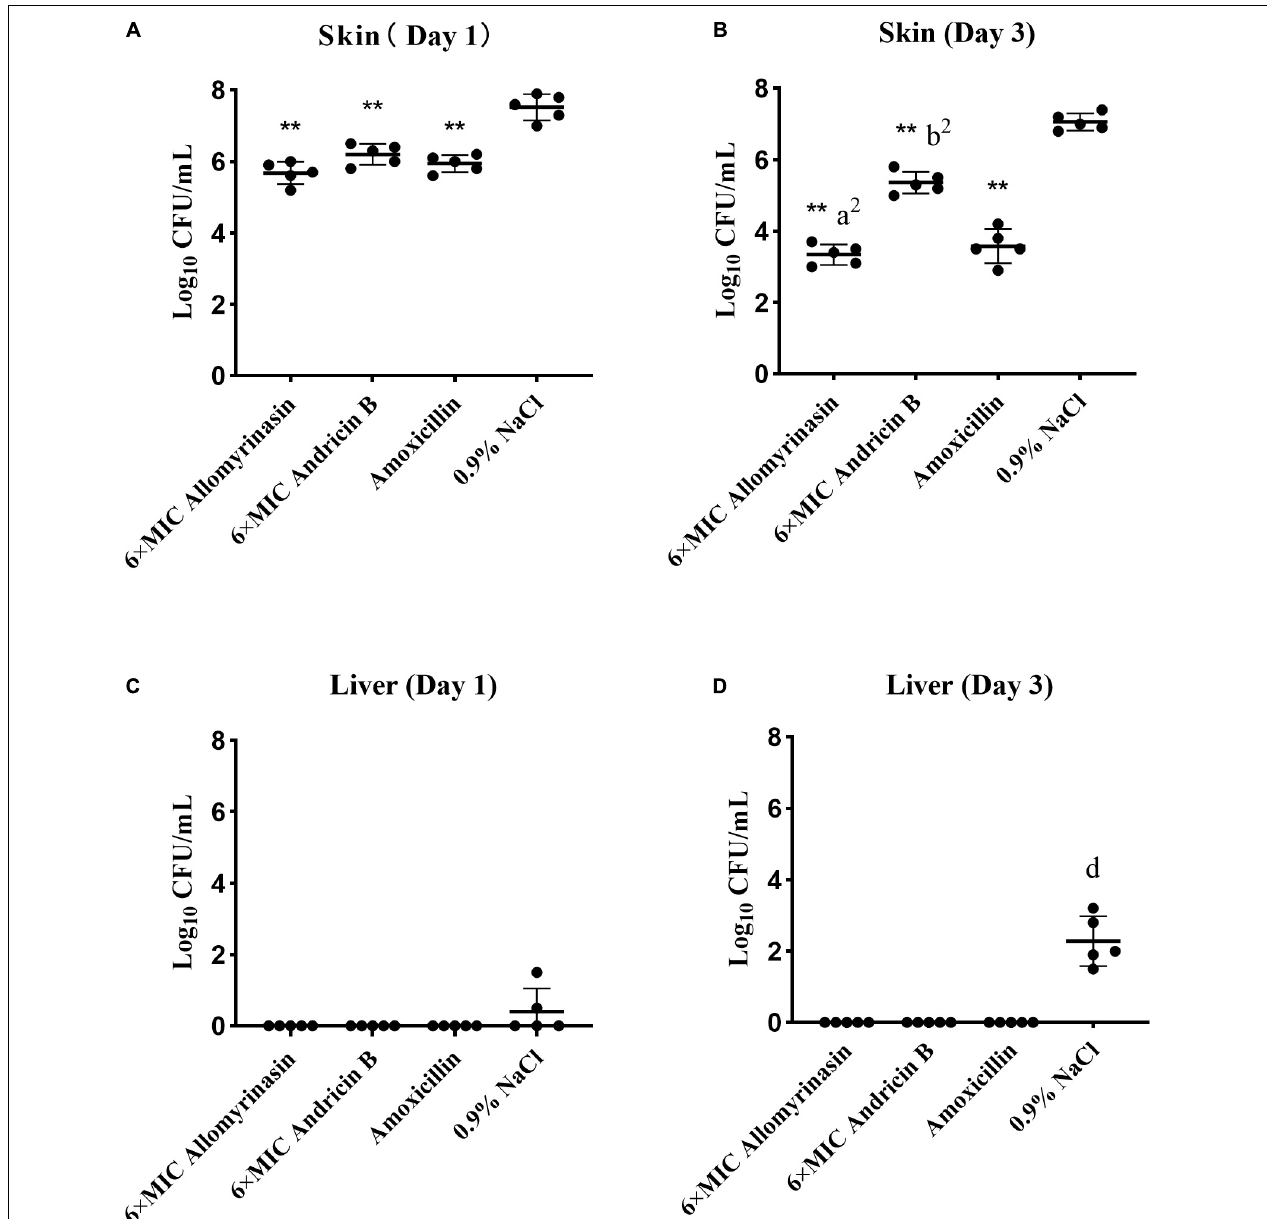
FIGURE 9 | (A–D) Efficacy of allomyrinasin and andricin B at 6 × minimal inhibitory concentration (MIC) on skin and hepatic infections in a mouse model of Staphylococcus pseudintermedius (MW767056) skin infection. The skin was treated daily with allomyrinasin, andricin B, amoxicillin, or 0.9% NaCl after inoculation of 5 × 10 6 CFU of S. pseudintermedius MW767056. The mean bacterial counts (log 10 CFU/g) were measured on the first and third days after inoculation with S. pseudintermedius . Data are presented as means ± SD ( n = 5). * p < 0.05, ** p < 0.01, compared with saline group; a p < 0.05, a2 p < 0.01, compared with group treated with andricin B; b p < 0.05, b2 p < 0.01, compared with group treated with